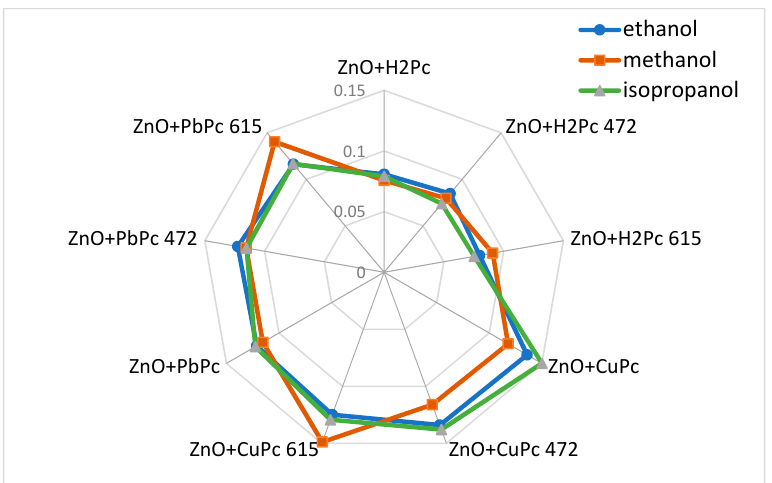
Figure 4. Chemical images of three alcohols built on the basis of responses of three sensors with ZnO-H 2 Pc, ZnO-CuPc, and ZnO-PbPc layers and virtual ones that are the same sensors operating under illumination by 472 nm and 615 nm LEDs.